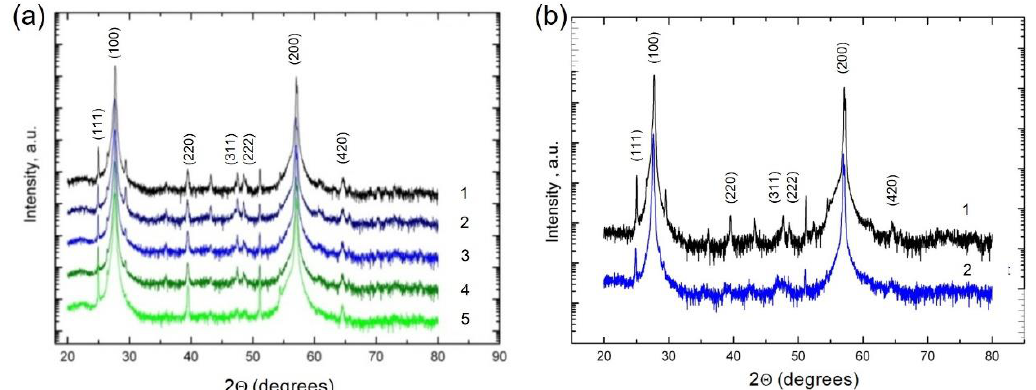
Figure 3. XRD spectra of PbTe:In films on polyimide substrate in a semi logarithmic scale: ( a ) Pb 0.99 In 0.01 Te grown at varied substrate temperatures. Numbers correspond to different substrate temperatures: 1—523 K, 2—548 K, 3—573 K, 4—598 K, 5—638 K; ( b ) Pb 0.995 In 0.005 Te of 3 µ m thickness ( T S = 623 K) before (1) and after (2) heat treatment.